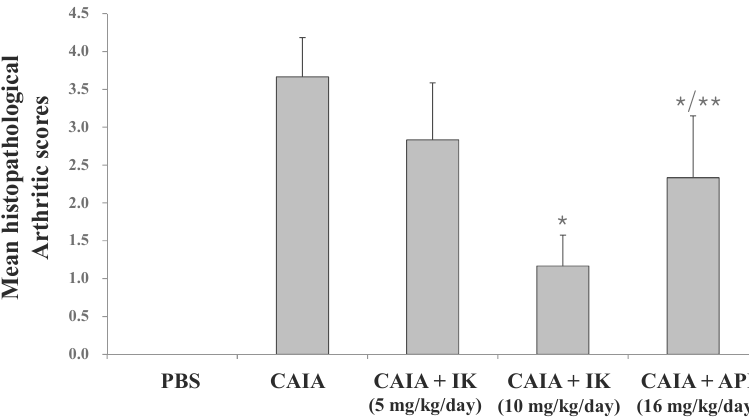
Figure 2. Effect of IK and API on mean histopathological arthritis scores in CAIA mice . Results were expressed as a score (means ± SD) of six mice. * p <0.05 vs. CAIA-group and ** p <0.05 vs. IK(10 mg/kg)- group.